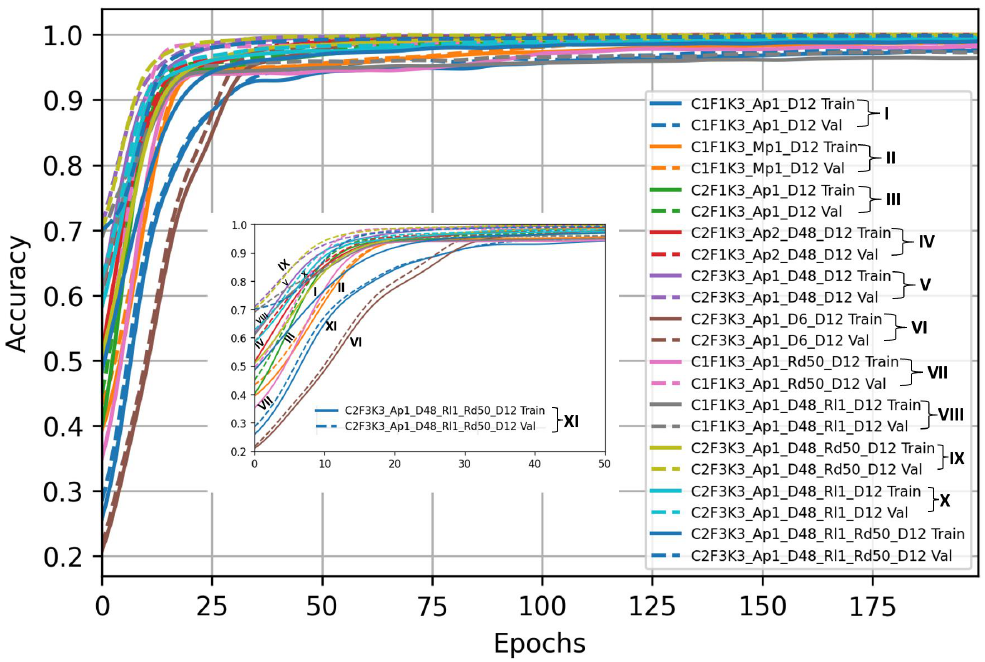
Figure 5. Accuracy on training and validation data for the considered CNN model architectures. Table 2. Overview of CNN model architectures. The accuracy is calculated at the 200th epoch. The filter kernel size is three, the pool size is two, and padding is valid with stride of